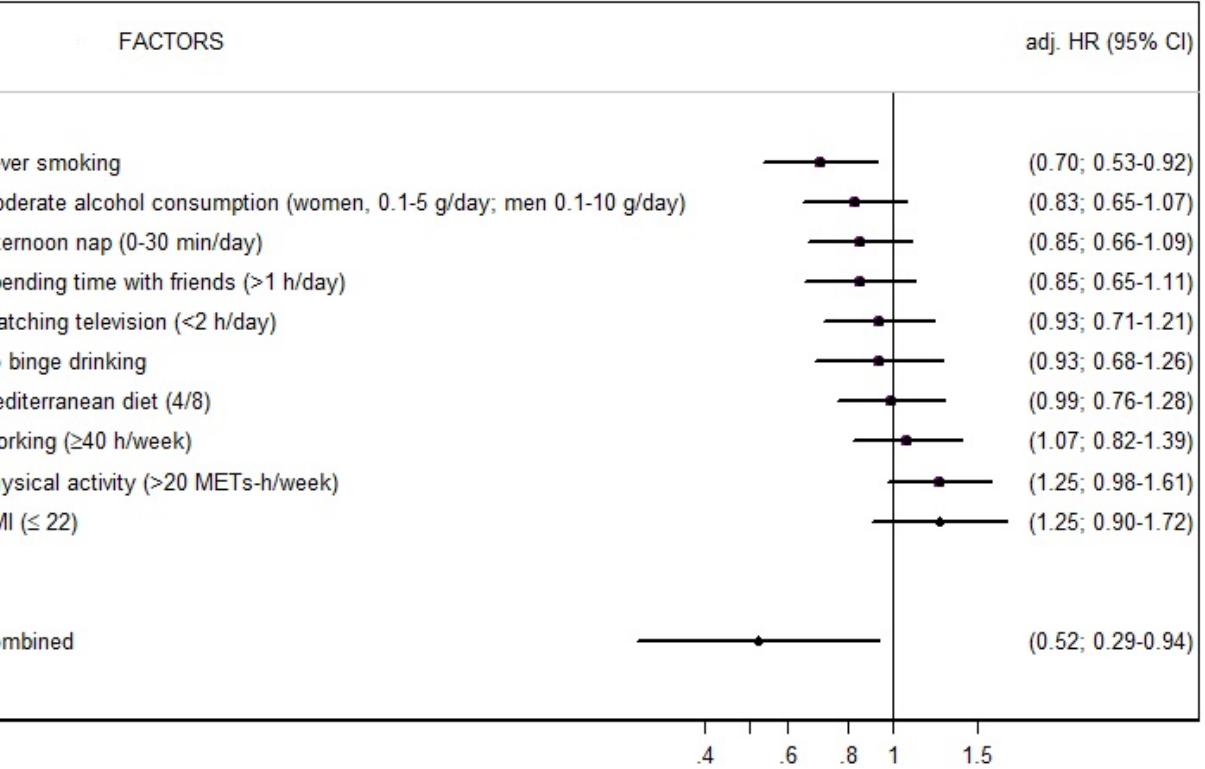
Figure 2. Risk of glaucoma incidence for each factor of the SUN Healthy Lifestyle Score. (The SUN Project). Adjusted for age, sex, calorie intake, caffeine intake, alcohol intake, omega-3/omega-6 ratio, prevalence of cancer, prevalence of hypertension, prevalence of diabetes mellitus type 2, educational level, and following a special diet. Table 3. Contribution of each point to the total variability in the Healthylife Score. (SUN project).